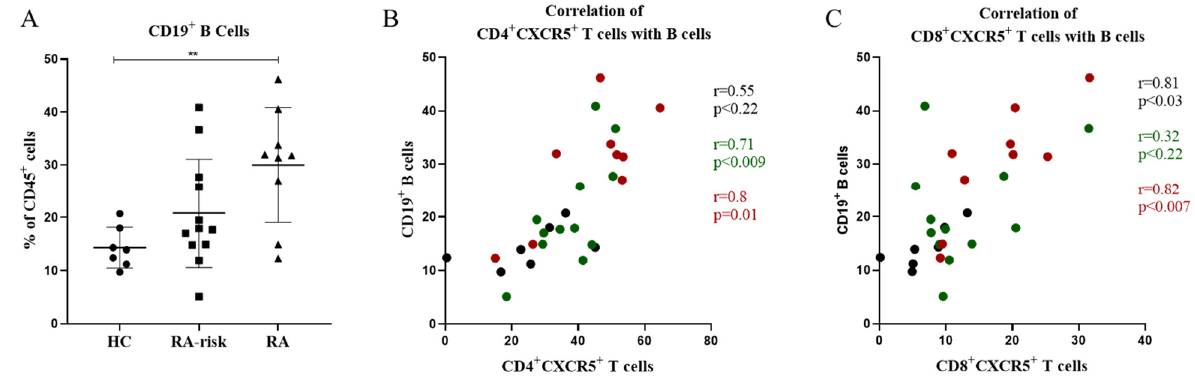
Figure 3. Correlation of CD19 + B cells with CD4 + follicular helper and CD8 + follicular T cells in LNs. ( A ) Frequencies of CD19 + B cells in LNs are shown for HCs (n = 7), RA-risk (n = 12), and early RA (n = 9) patients. ( B ) Correlation between the frequencies of CD4 + CXCR5 + Tfh cells and the frequencies of CD19 + B cells in LNs. ( C ) Correlation between the frequencies of CD8 + CXCR5 + follicular T cells and the frequencies of CD19 + B cells in LNs. Black dots represent correlations in healthy controls, green dots represent correlations in RA-risk individuals, and red dots represent correlations in early RA patients. Error bars represent mean with SD. For statistical analysis, Kruskal–Wallis or one-way ANOVA (when appropriate) was performed, and significant differences are indicated as ** p <0.01. All symbols represent data from single individuals (• healthy controls (HC); ■ RA-risk individuals (RA at-risk); ▲ early RA patients (RA)).